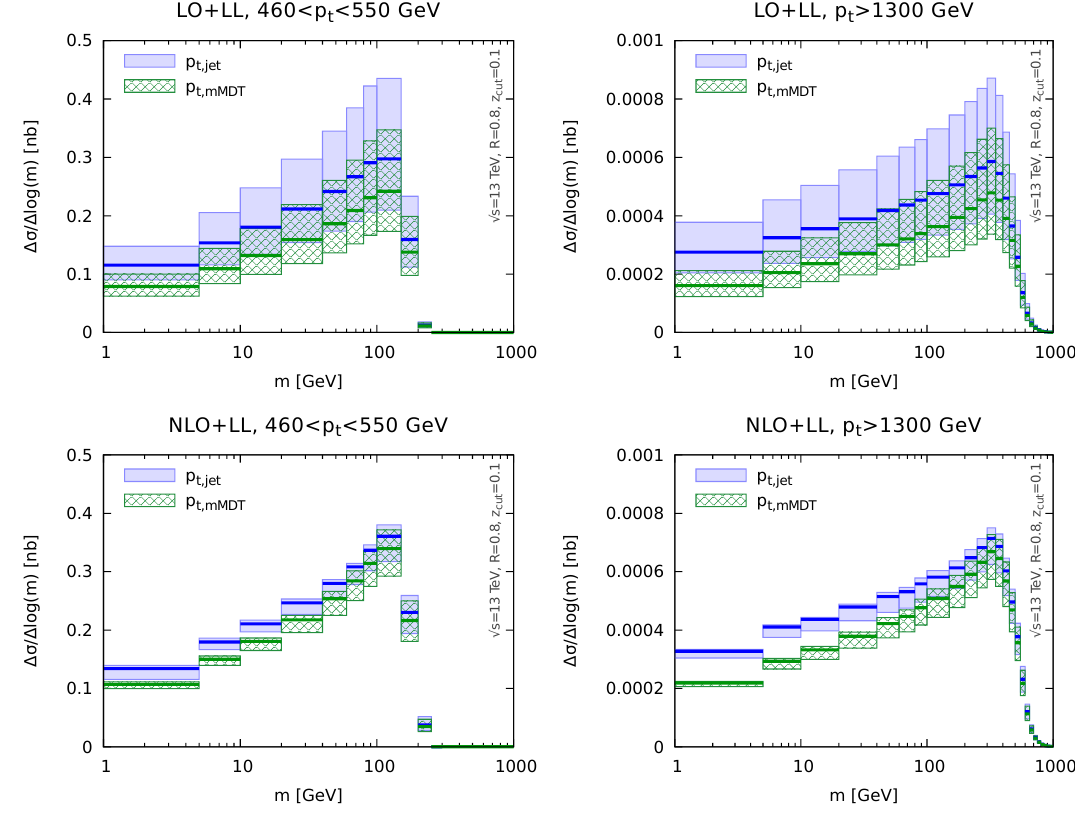
Figure 8 . In this (cid:12)gure we compare resummed and matched jet mass distributions in the case of ungroomed p t; jet selection (blue) or groomed p t; mMDT selection